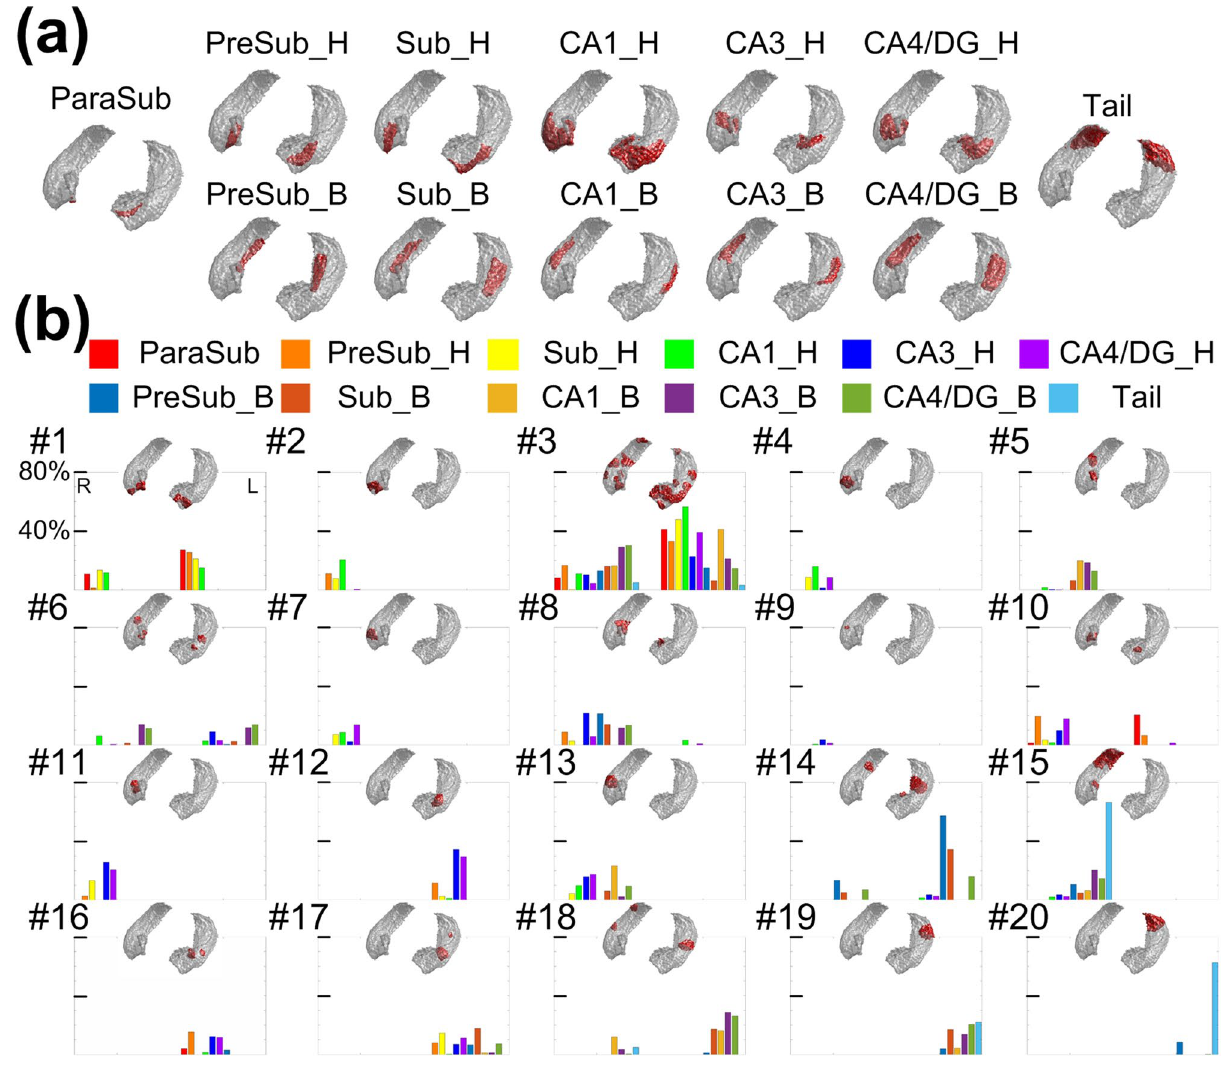
Figure 2. Anatomically and functionally defined hippocampal subfields and their spatial relationships. ( a ) Surface reconstruction of aHPSF. ( b ) Surface reconstruction of fHPSF and the percent of spatial overlap between aHPSF and fHPSF. The overlapped percentages with different aHPSFs are color-encoded as indicated in the figure legend. The indices of fHPSFs were arranged from anterior to posterior. The index #1 was assigned to the most anterior fHPSF and #20 to the most posterior